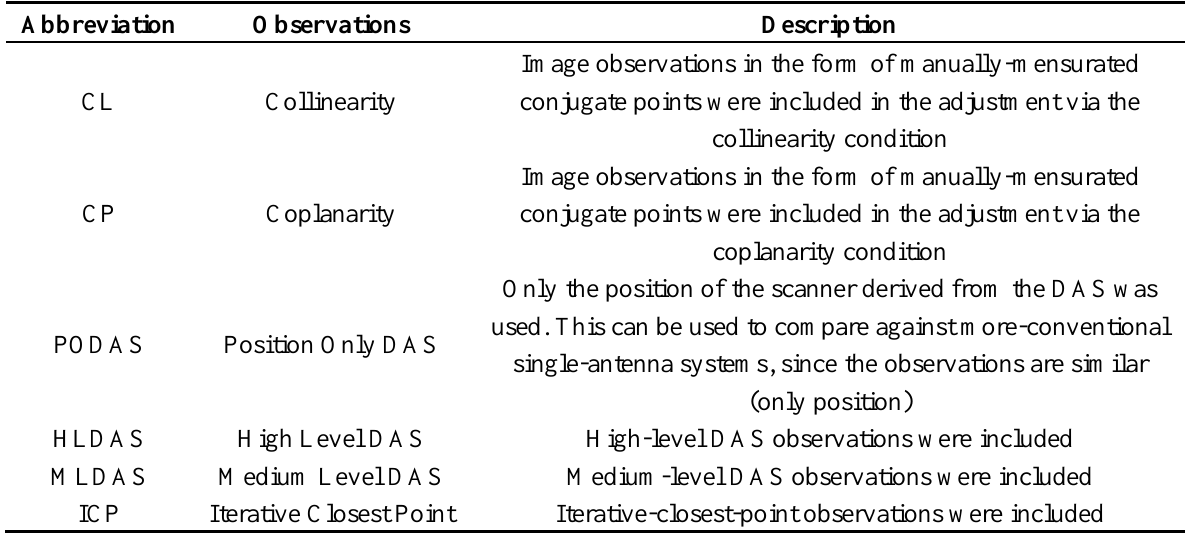
Figure 4. Single-station point clouds at Site 1 from approximately the perspective of Station 3 looking northeast ( top ), and Site 2 from approximately the perspective of Station 1 looking northeast ( bottom ). Table 1. Observation